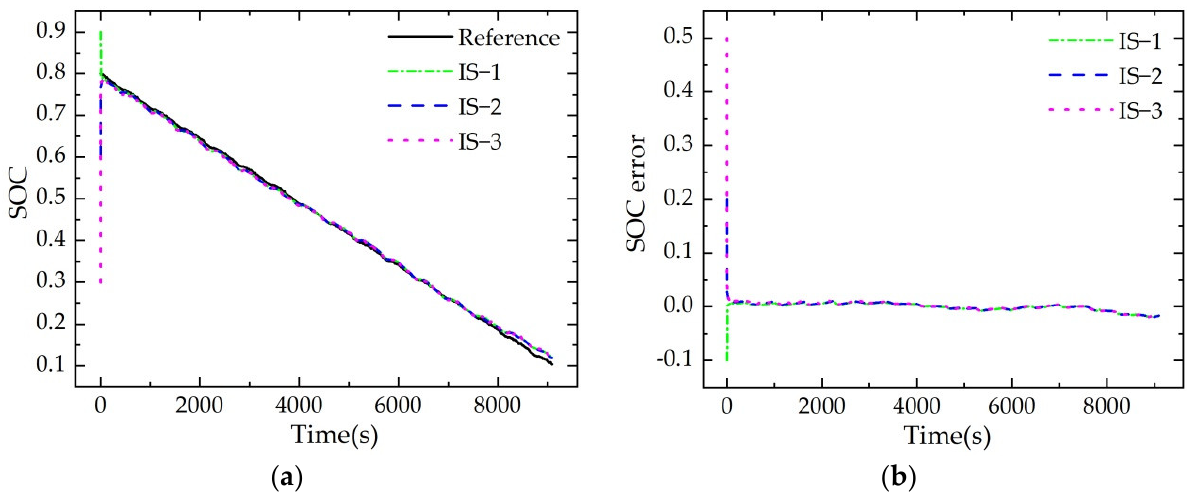
Figure 16. SOC estimation results in three cases under the US06 test: ( a ) the estimated SOC; ( b ) the SOC error.